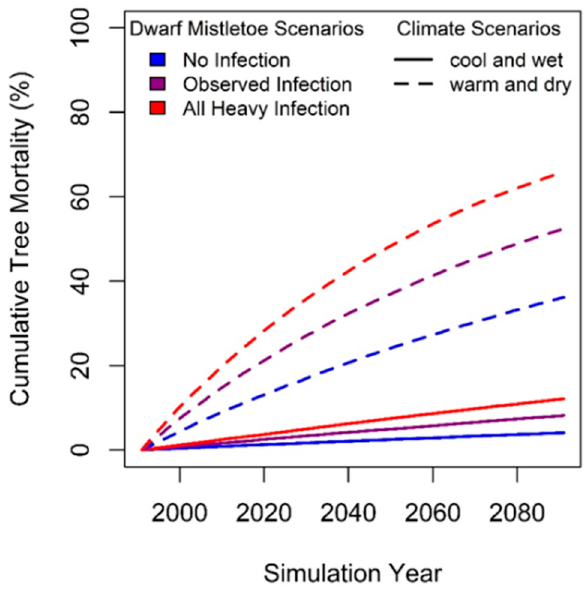
Figure 5. Simulation results indicate that both dwarf mistletoe infection and warm and dry climates synergistically increase cumulative western hemlock tree mortality over 100 years. We present the mean cumulative percent tree mortality by year for 40 simulations of each dwarf mistletoe and climate scenario using the statistical models developed in [65].